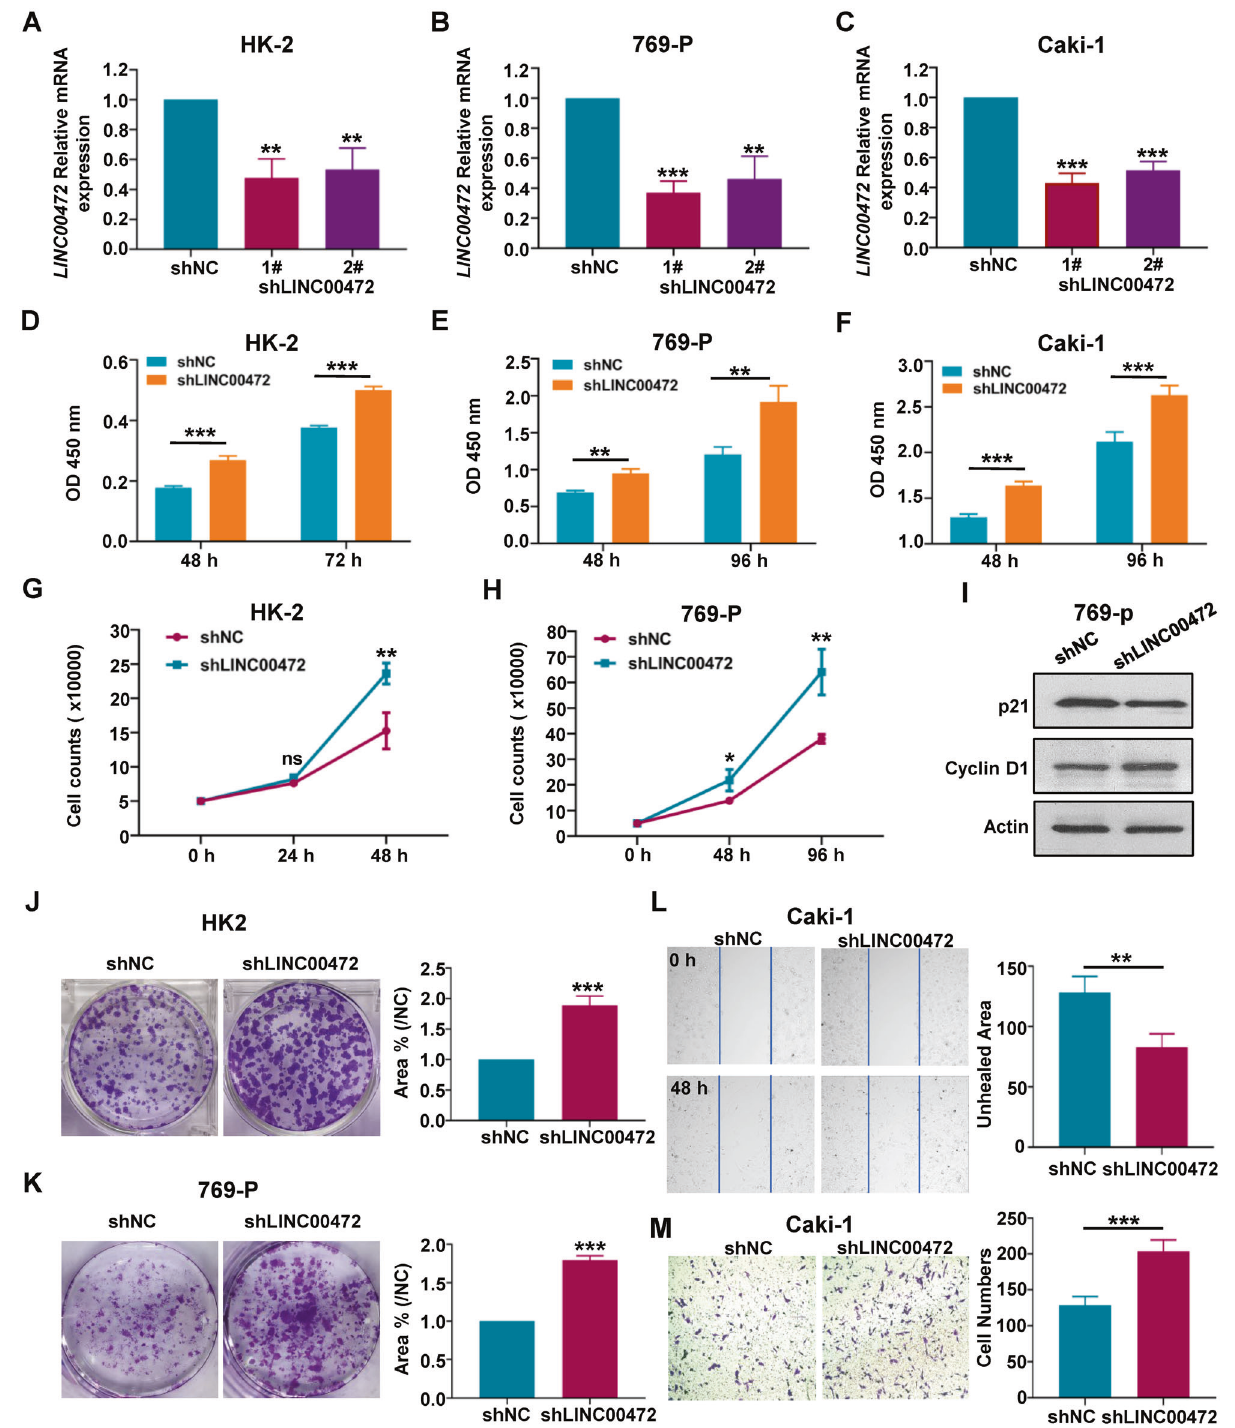
Fig. 3 Inhibition of LINC00472 promotes cell proliferation and migration. HK-2 ( A ), 769-P ( B ), and Caki-1 ( C ) cells were transfected with control shRNA vectors (shNC) and the Lentivirus-based LINC00472-targeting shRNA (shLINC00472-1# and shLINC00472-2#), and the inhibition ef fi ciency of lentivirus interference plasmid was detected by RT-qPCR. Cell Counting Kit-8 test was used to detect the proliferation of HK-2 ( D ), 769-P ( E ), and Caki-1 ( F ) cell lines. G , H Cell counts was used to compare the proliferation rate of LINC00472 stable knockdown cell line and control cell line of HK-2 ( G ) and 769-P cells ( H ). I The expression of cell proliferation-related proteins in 769-P shNC and 769-P shLINC00472 cell lines was detected by using western blot. J Colony formation assay of HK-2-shLINC00472 cell line and HK-2-shNC cell line (Left). Statistics of clone formation Area (Right). K Colony formation assay of 769-P shLINC00472 cell line and 769-P shNC cell line (Left). Statistics of clone formation Area (Right). L Wound healing experiment was used to detect the migration of Caki-1 shLINC00472 cell line and the control cell line. M Using transwell to detect the migration of Caki-1 shNC and shLINC00472 cell line (Left). Statistics of migrating cell numbers (Right). In A – M , data were shown as mean ± SD of three independent experiments (* P < 0.05, ** P < 0.01, *** P < 0.001, ns non-signi fi cant).